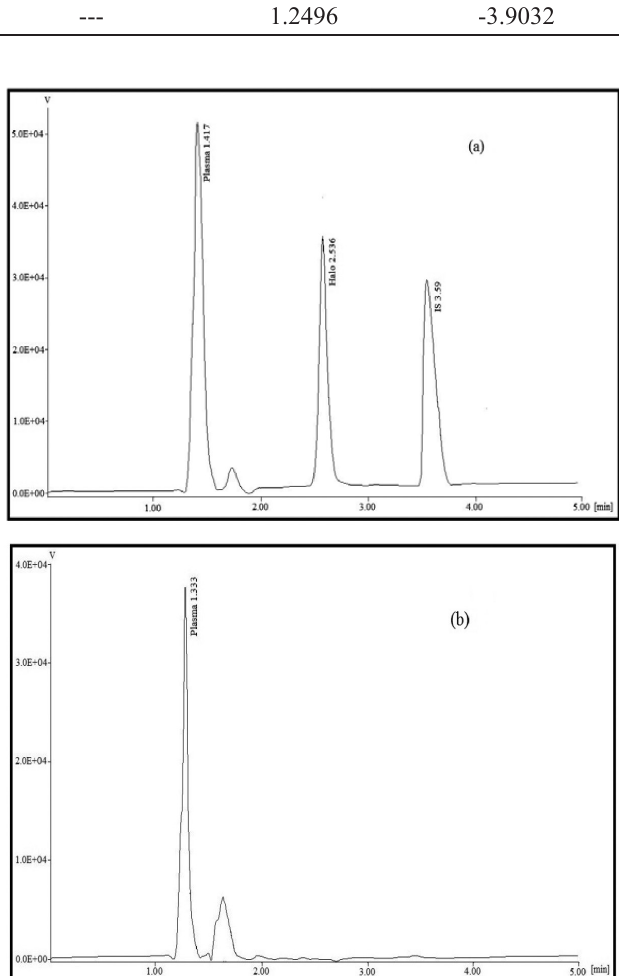
FIGURE 6 - HPLC chromatogram in (a) plasma spiked with drug and IS (b) blank